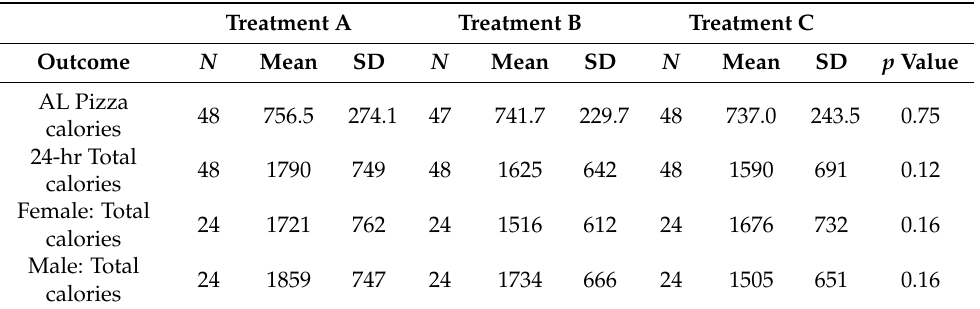
Table 5. Ad libitum pizza calories consumed and total calorie intake from 24-hr recall by treatment